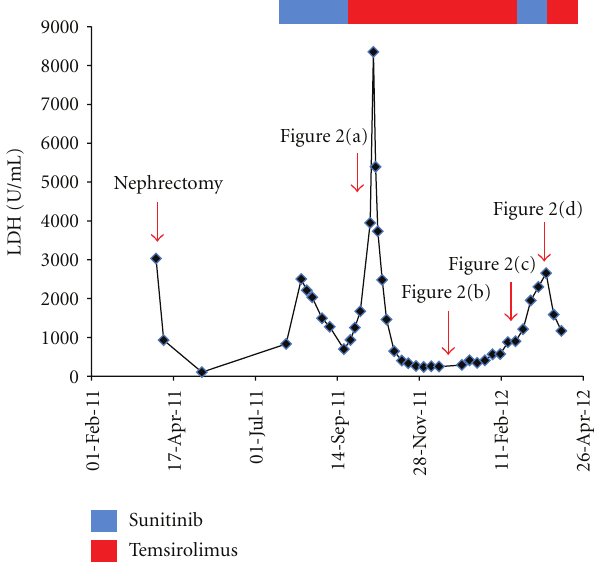
Figure 1: A chart of serum LDH level.